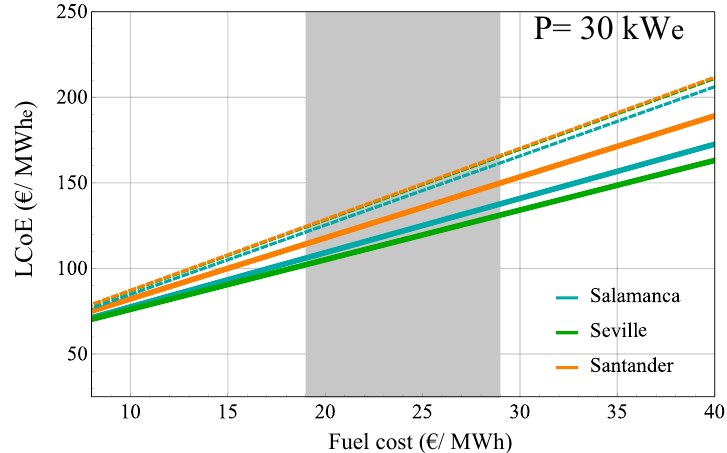
Figure 15. Evolution of the LCoE for the considered solar dish and the locations considered in a wide interval of natural gas prices. The shaded area corresponds to realistic actual prices in Spain, 2018 (around 26.41 e /MWh). The case shown corresponds to a power output of 30 kWe. Dashed lines refer to combustion-only mode and solid to solar hybrid